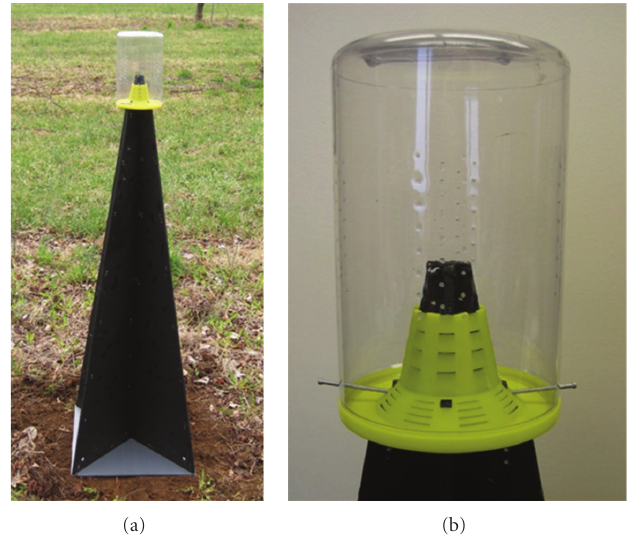
Figure 1: (a) Photo of pyramid trap and (b) jar top used in commercial orchards in